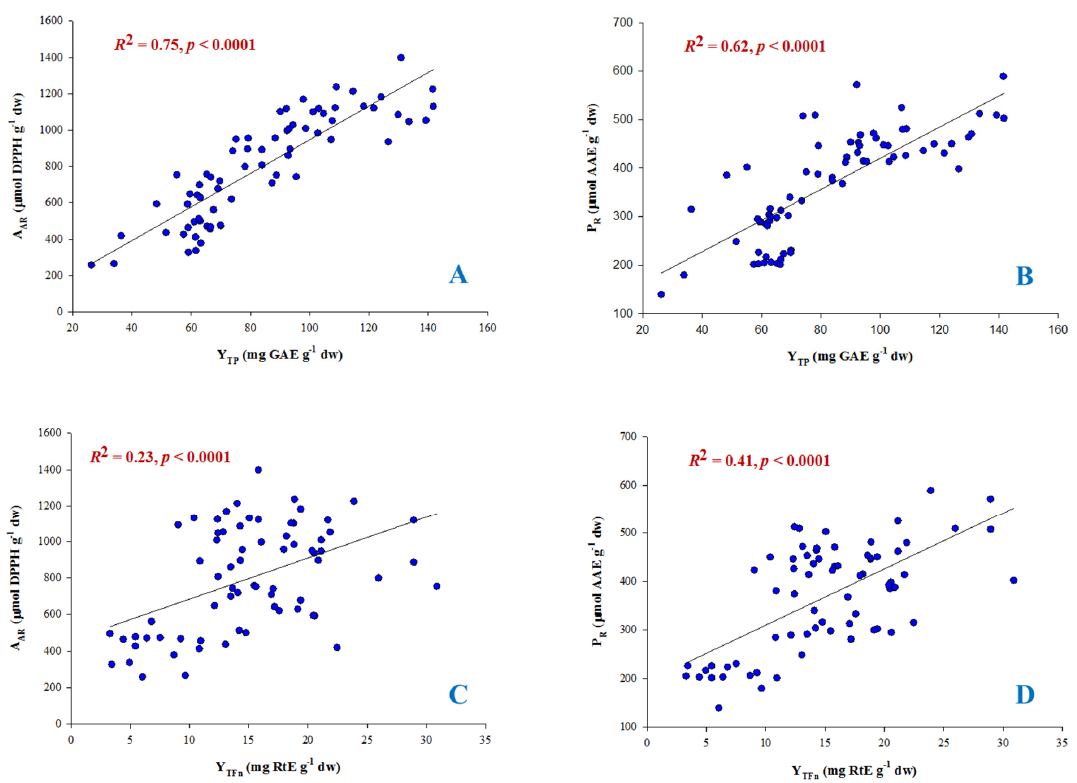
Figure 4. Plots illustrating linear regression between ( A ) Y TP and A AR , ( B ) Y TP and P R , ( C ) Y TFn and A AR and ( D ) Y TFn and P R .